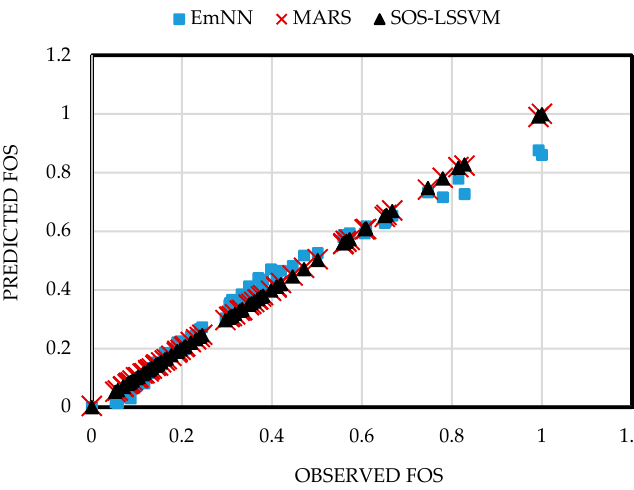
Figure 4. Performance curve for models.